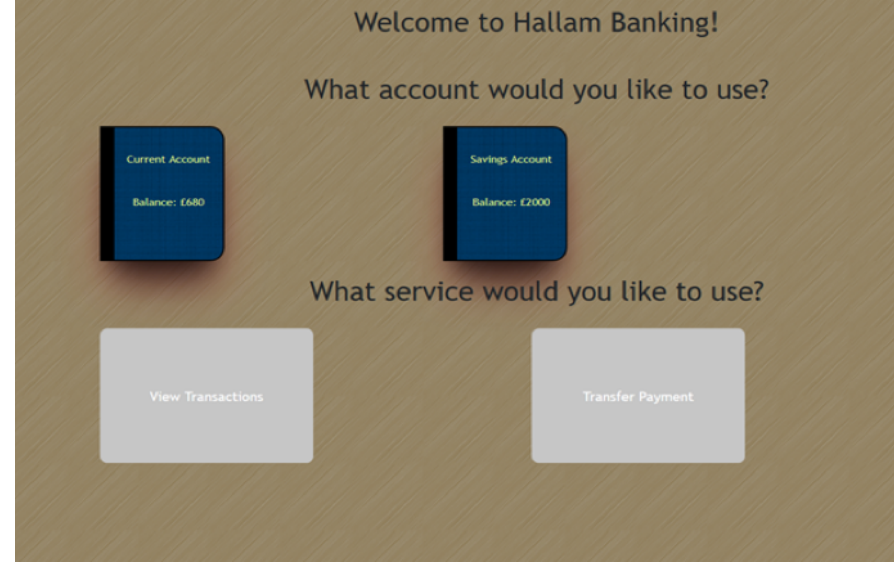
Figure 6. A screenshot of the main page of our skeuomorphic UI.